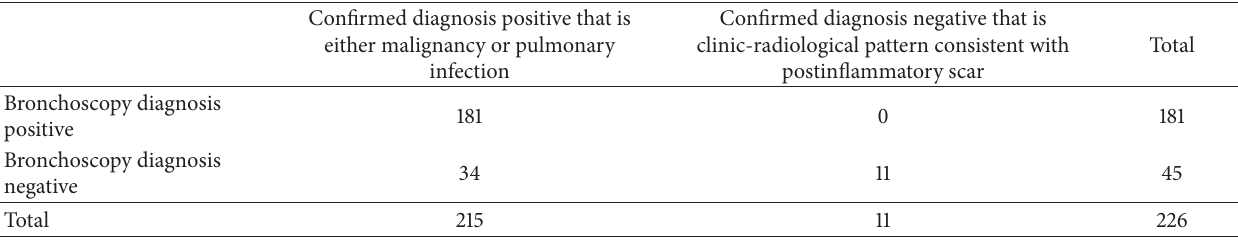
Figure 2: Diagnostic algorithm. 34 had nondiagnostic bronchoscopy and underwent repeated procedures with transthoracic CT-guided biopsy or surgical biopsy to obtain diagnosis. 11 out of 226 patients had nondiagnostic bronchoscopy results and were followed up with clinicoradiological surveillance. ∗ Stable after 24 months of clinicoradiological surveillance. ∗∗ Malignant disease: 22/25 were NSCLC of which 15 were adenocarcinoma, 1 was squamous cell carcinoma, and 6 were undifferentiated NSCLC. The other 3 were B cell lymphoma and metastatic breast carcinoma and the last patient was deceased but had a scan after TBLB with radiological evidence of metastatic cancer of unknown primary. ∗∗∗ Infection: out of 8 cases, 5 were Mycobacterium tuberculosis complex, 1 nontuberculous Mycobacterium , and 2 fungal infections. Table 3: Sensitivity and specificity of